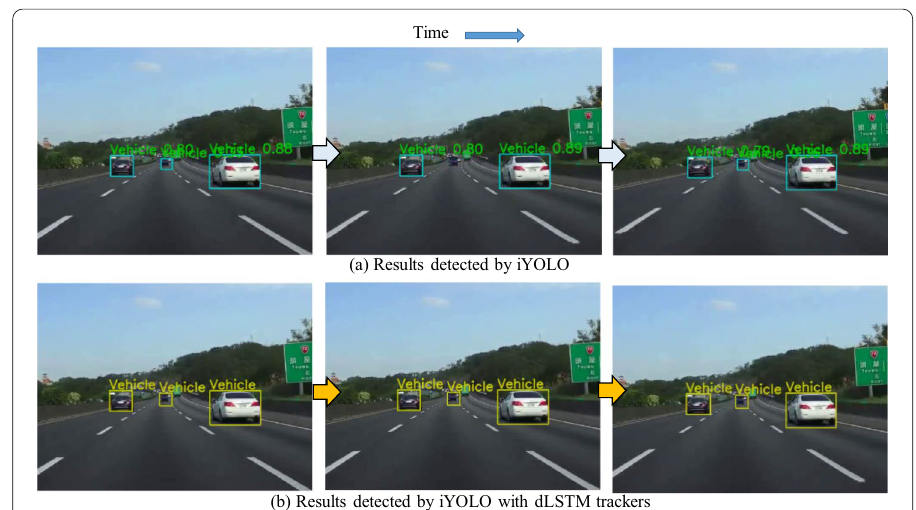
Fig. 11 Visual results of video set #1 achieved by: a iYOLO detector only; b the iYOLO with dLSTM refiners